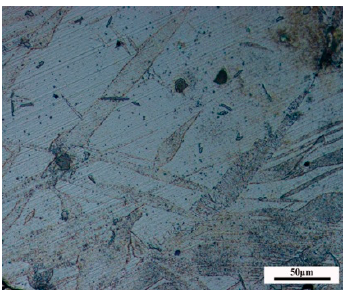
Figure 5. Optical micrographs of AZ91-1.0%Pr alloy after T6 heat treatment.